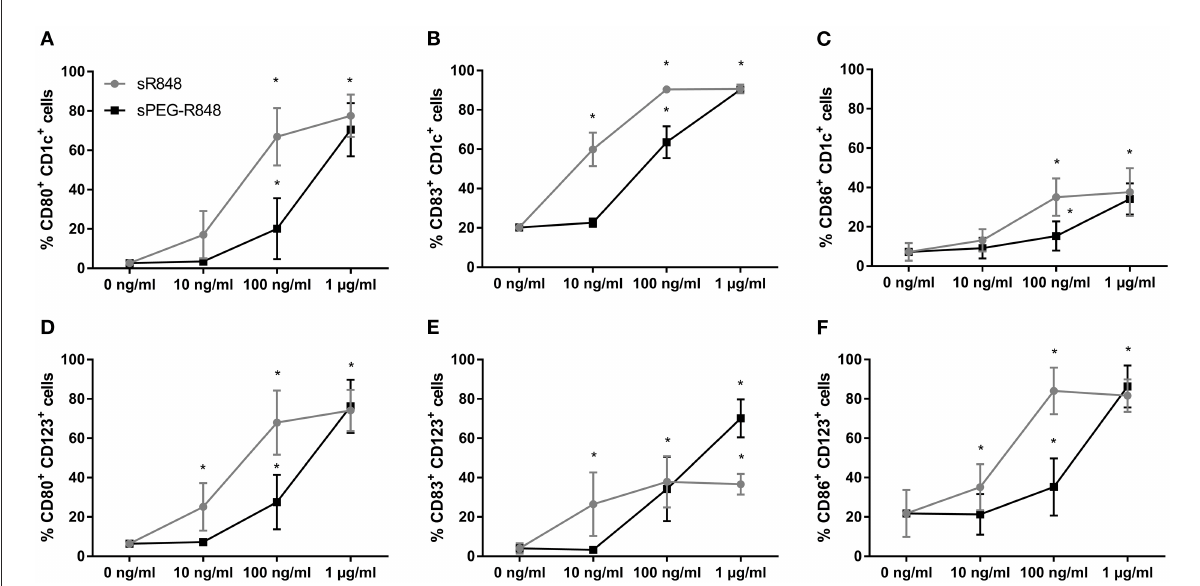
FIGURE4 R848 retains stimulatory activity after PEGylation. Flow cytometric analysis of adult CD1c + (A–C) and CD123 + (D–F) DCs after stimulation with different concentrations of R848 and PEG-R848 for 20h. CD80- (A,D) , CD83- (B,E) and CD86-expressing (C,F) cells were evaluated. Data represent the means ± SD ( n = 3). Significantly greater than cells incubated with 0 ng/ml: * P < 0.05 (two-way ANOVA).